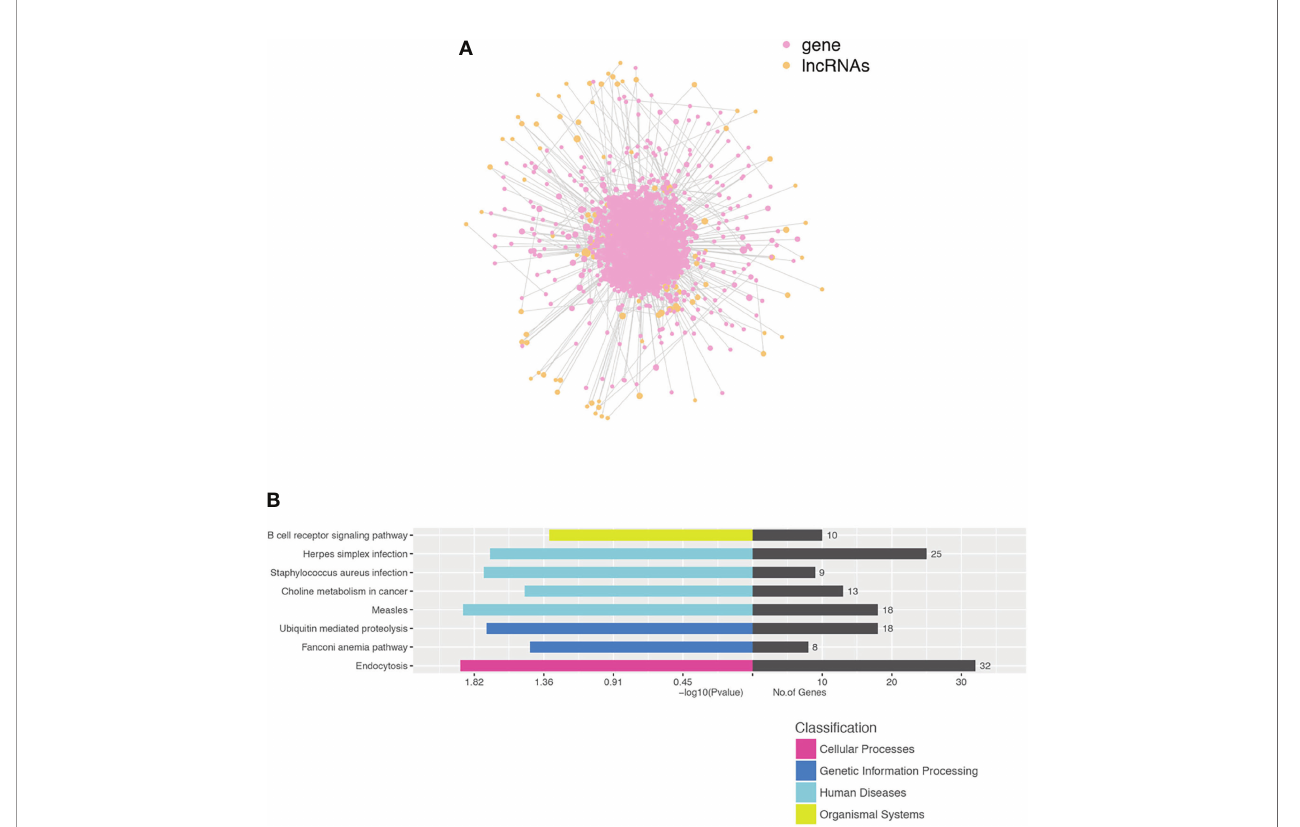
FIGURE 6 | Construction of the lncRNA and protein-coding gene co-expression network. (A) LncRNA-TF core network consisting of the top 200 pairs of lncRNAs and TF with the most relevance. TF transcript factor. (B) Functional enrichment in each cluster indicated that lncRNAs were functionally associated with mRNAs in particular biological processes.